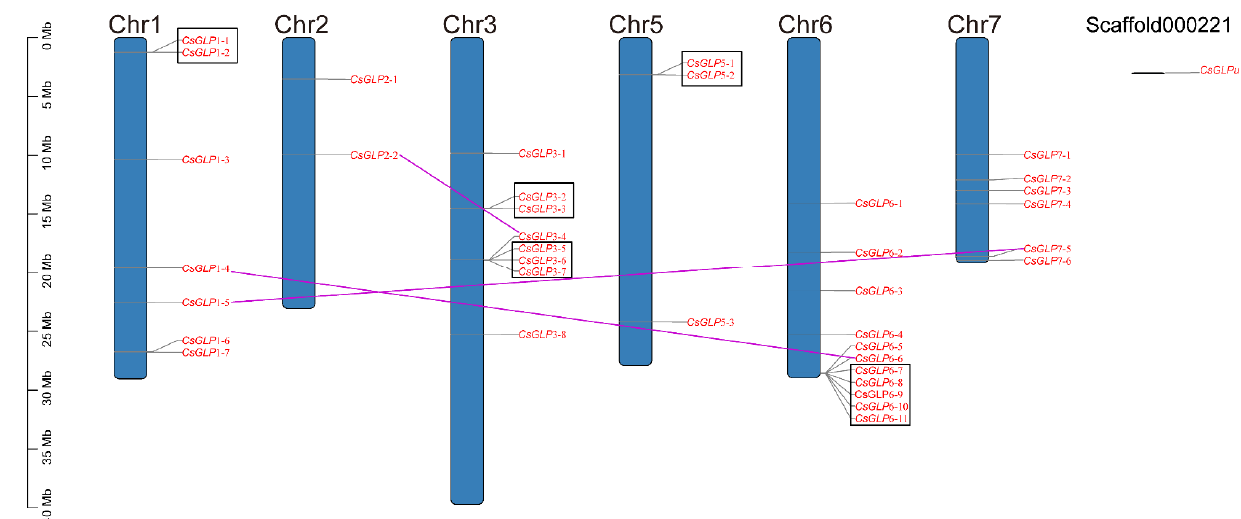
Figure 4. Chromosomal distributions and gene duplications of GLP genes in cucumber genome. The chromosome numbers are shown at the top of each chromosome.